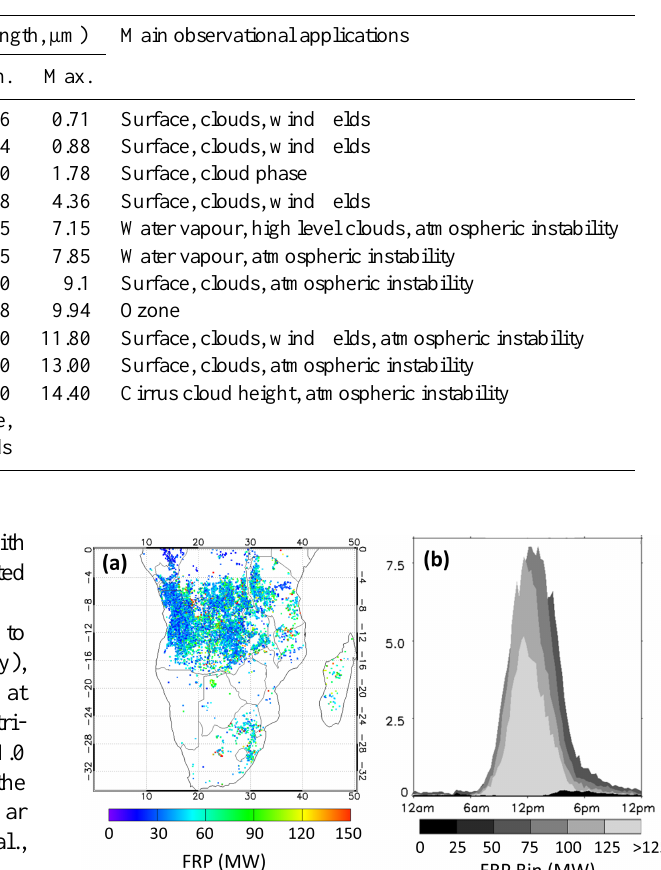
Table 1. Spectral bands of Meteosat SEVIRI.